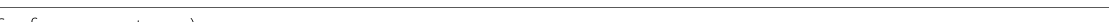
figure on next Fig. 8 TA inhibits the activation of NLRP3 inflammasome might via the AMPK/ULK1‑ and Raf/MEK/ERK‑mediated autophagy in APP/PS1 mice. A The Western blotting detection of the protein expressions of LC3, NLRP3, caspase 1, and IL‑1β in the brain tissues of NC and APP/PS1 mice. The bar chart indicates the ratios of LC3‑II/β‑actin, NLRP3/β‑actin, caspase‑1 (p10)/Pro, and IL‑1β (p17)/Pro. B Representative immunohistochemistry and immunofluorescence staining images showing the expressions of NLRP3, TREM2, GFAP, LC3, and CD45 in the hippocampus of NC and APP/ PS1 mice. Magnification: 20; scale bar: 100 μm. Bar charts indicate the quantifications of NLRP3 expression, and the cells with TREM2 + /DAPI + , × GFAP + /DAPI + , and LC3 + , CD45 + , and the colocalization of LC3 + with CD45 + ( n 4). C The Western blotting detection of the protein expressions = of p‑AMPK, AMPK, p‑ULK1(555), ULK1, p‑RAF, RAF, p‑MEK, MEK, p‑ERK, ERK, and β‑actin in the brain tissues of NC and APP/PS1 mice. The bar chart indicates the ratios of p‑AMPK/AMPK, p‑ULK1(555)/ULK1, p‑RAF/RAF, p‑MEK/MEK, p‑ERK/ERK. Error bars, S.D., * p 0.05, ** p 0.01, *** p 0.001. The ≤ ≤ ≤ full‑length blots are presented in Additional file 1: Fig.